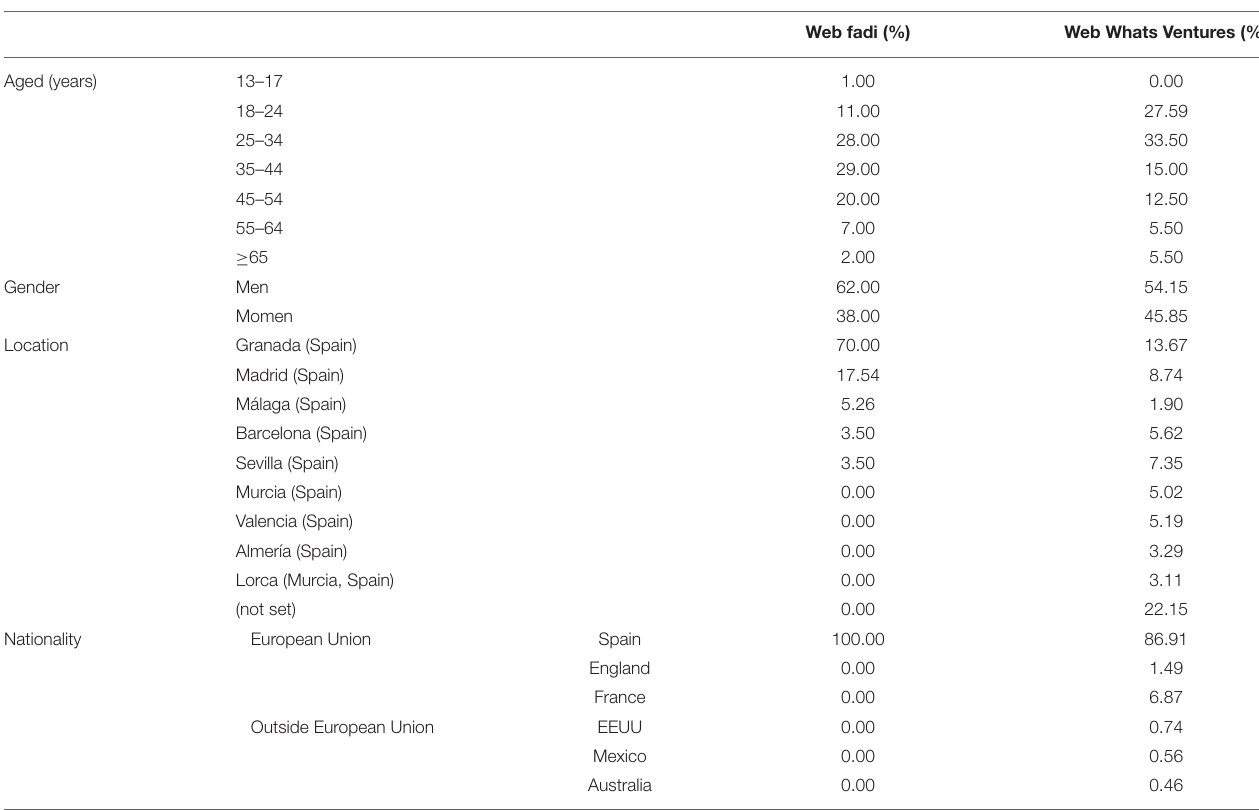
TABLE 6 | People who have